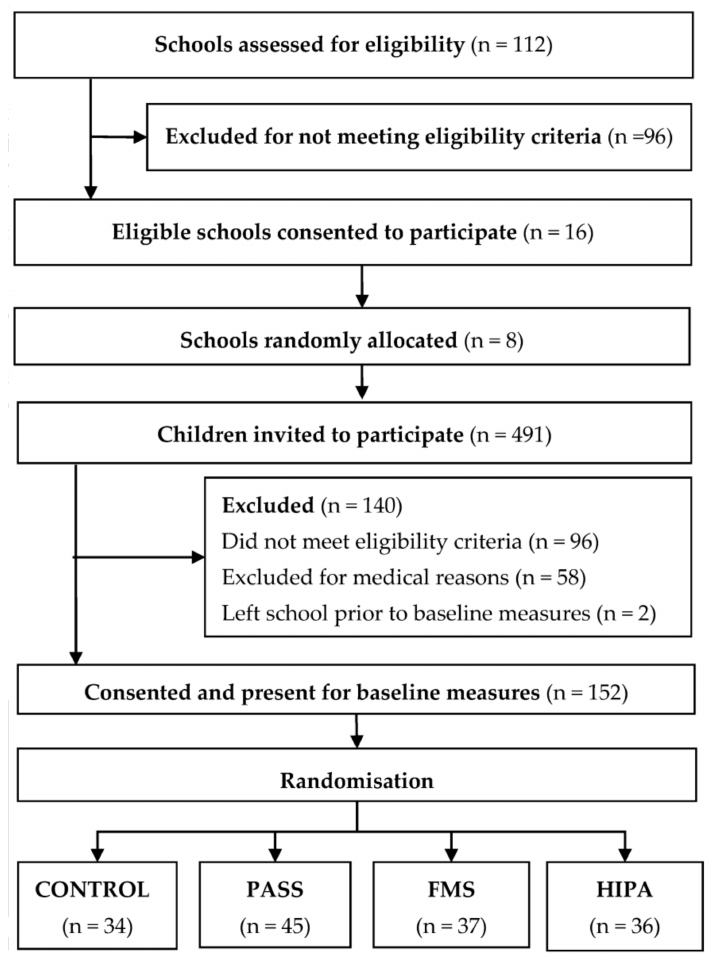
Figure 2. School and participant flow to baseline assessments. Note: HIPA, High Intensity Physical Activity intervention; FMS, Fundamental Movement Skill intervention; PASS, Physical Activity Signposting Scheme intervention. Table 2. Descriptive statistics for